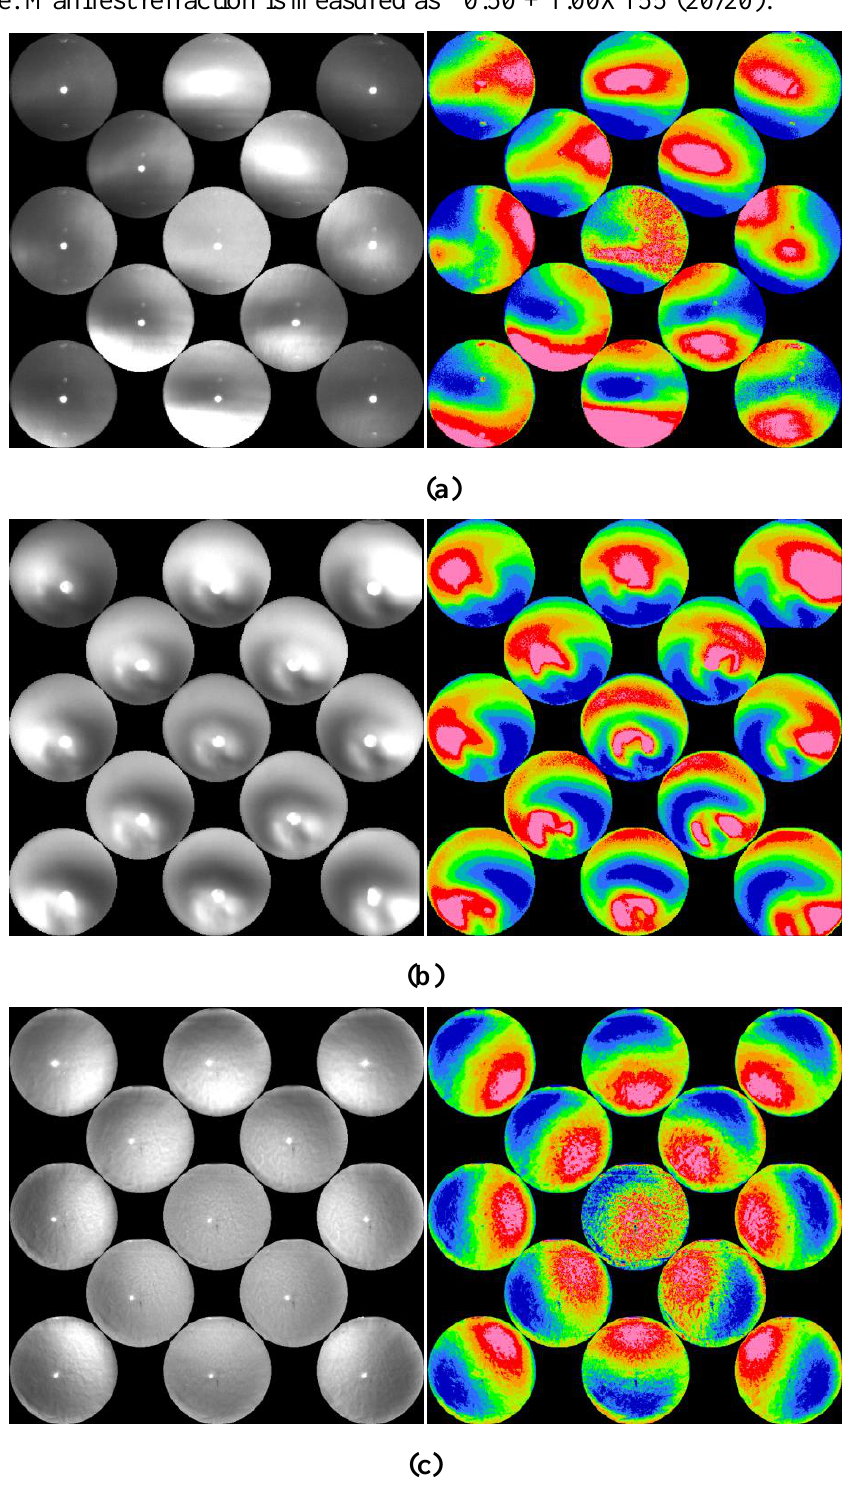
Figure 9. ( a ) Example of a typical keratoconus eye images. Manifest refraction was measurement as RE-0.50DS + 1.50DCX003 and BCVA of 20/20. Scissors reflexes are evident. ( b ) Gray-scale and color maps of a severe case of keratoconus. Manifest refraction was measurement as −6.00DS + 5.00DCX115 (20/80). ( c ) Image of a typical case